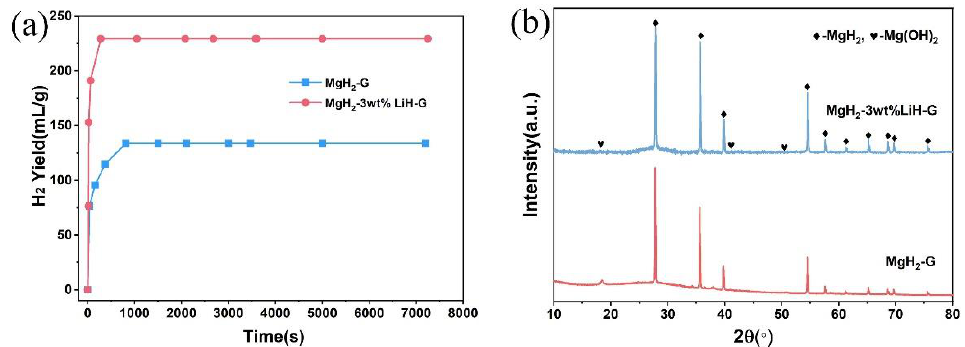
Figure 1. ( a ) The hydrogen generation curves and ( b ) XRD patterns of the hydrolysis byproduct of MgH 2 -G and MgH 2 -3 wt % LiH-G.